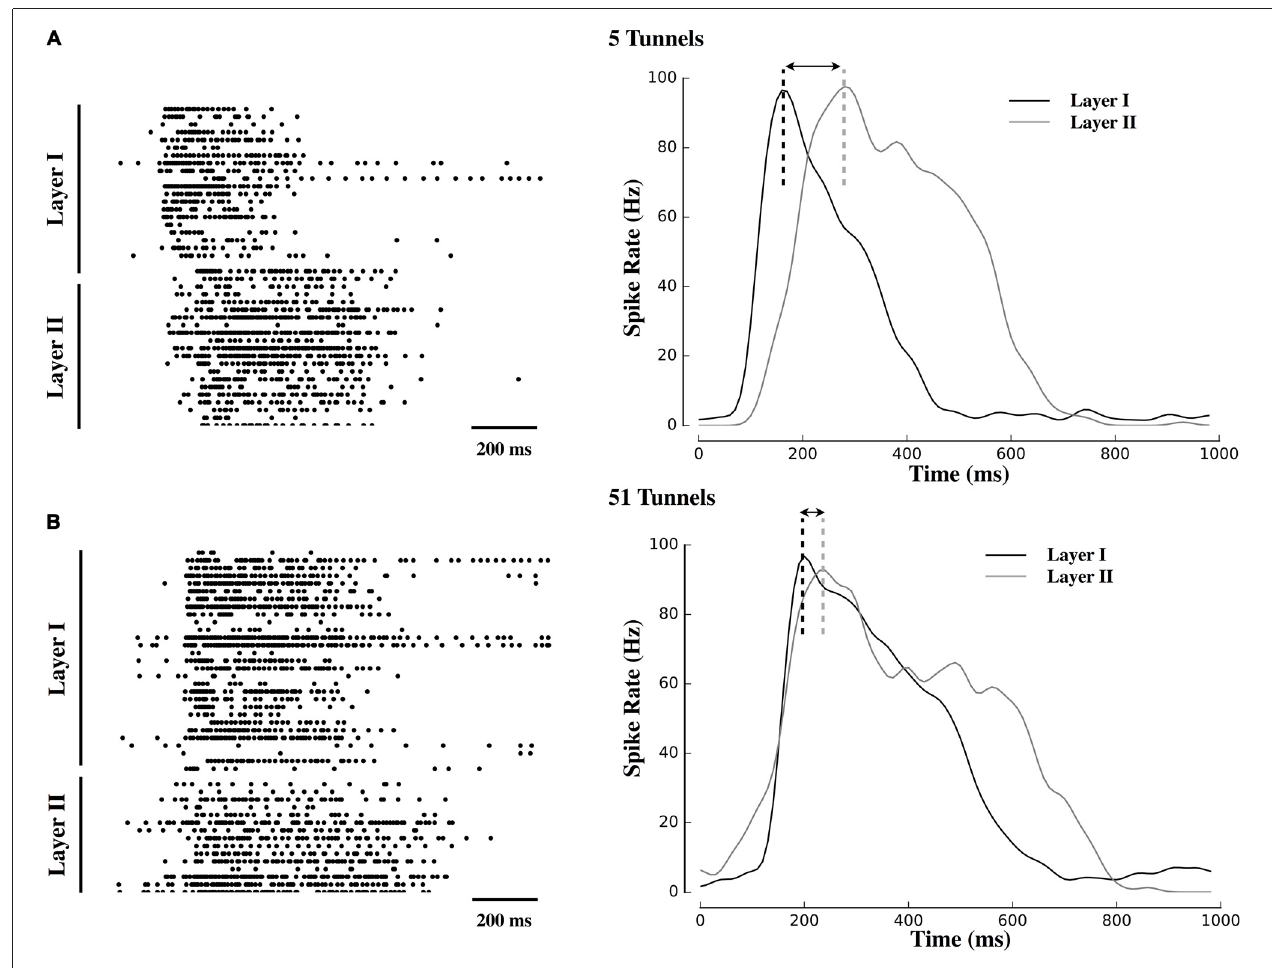
FIGURE 2 | Delayed propagation of population bursts within decreasing number of tunnels . Raster plots and associated activity histograms during a propagating burst event from a single microelectrode array (MEA) culture in Group 5T (A) and Group 51T (B) . Increasing the number of pathways decreased the delay (indicated with arrows) with which spontaneous bursts in Layer I were able to propagate into Layer